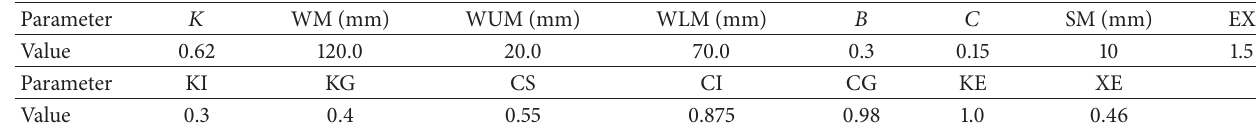
Table 2: Parameters for Xin’anjiang model after calibration.